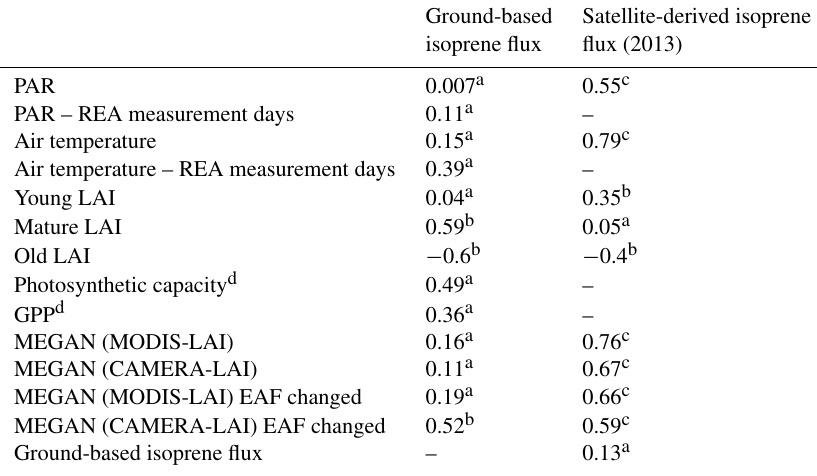
Table 2. Correlation coefficient, R 2 , of regressions for ground-based isoprene flux, satellite-derived isoprene flux, environmental factors, biological factors, and MEGAN 2.1